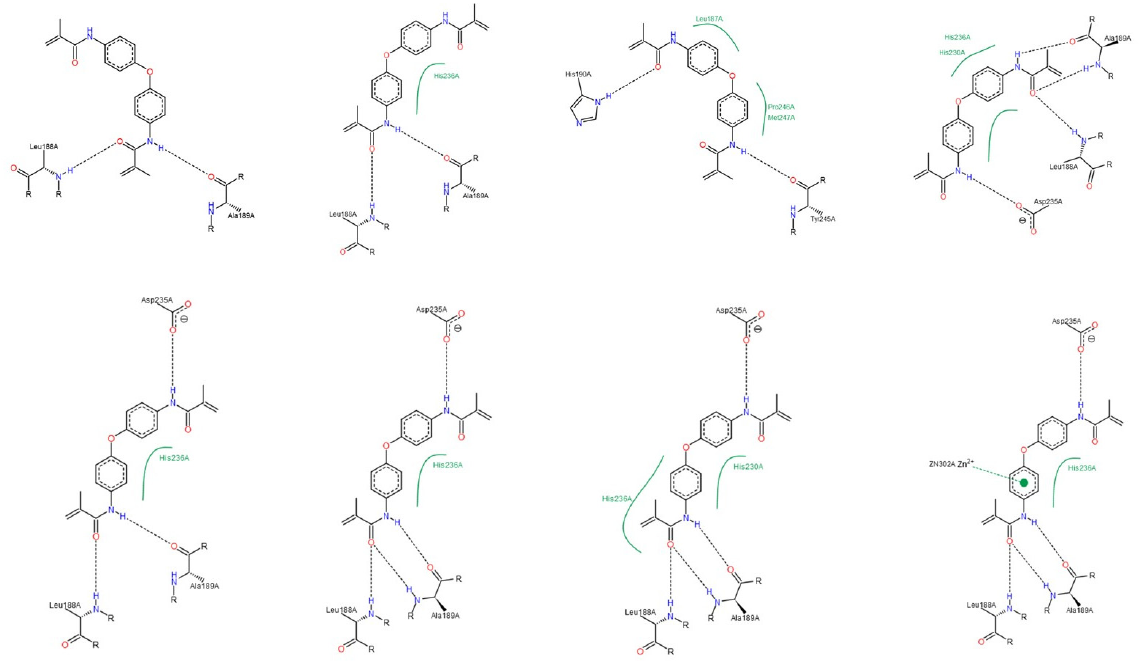
Figure A18. Interactions between compound C and MMP-8, by PoseView calculations.